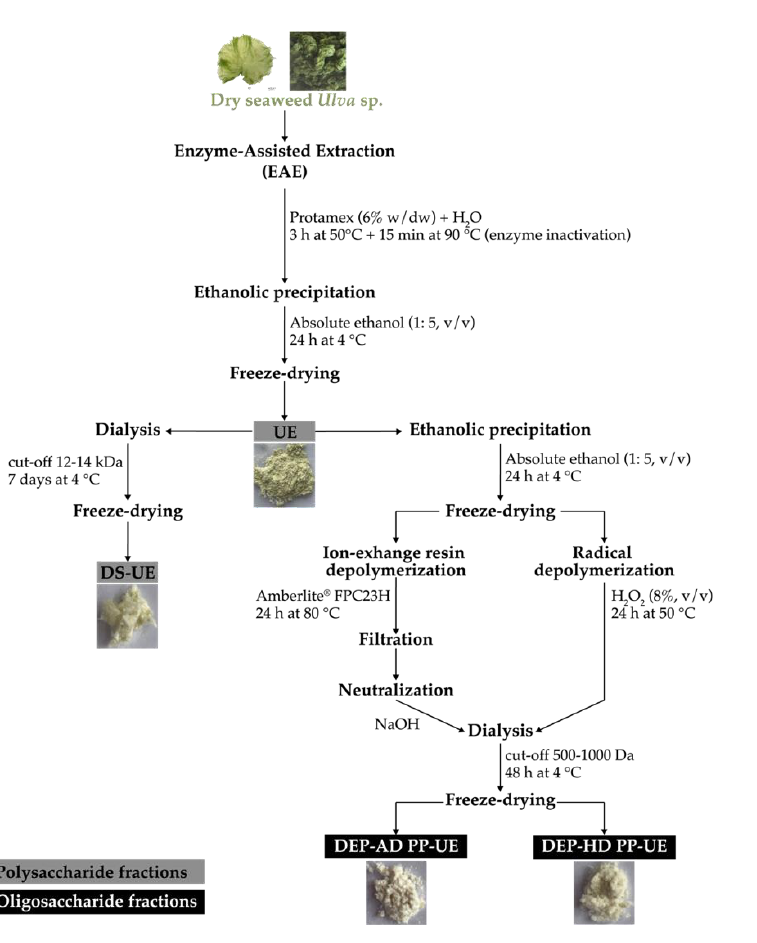
Figure 9. Detailed procedures for poly- and oligosaccharide Ulva sp.-derived EAE fractions [16]. Table 1. Description of poly- and oligosaccharide Ulva sp.-derived EAE fractions and their obtention process [16].